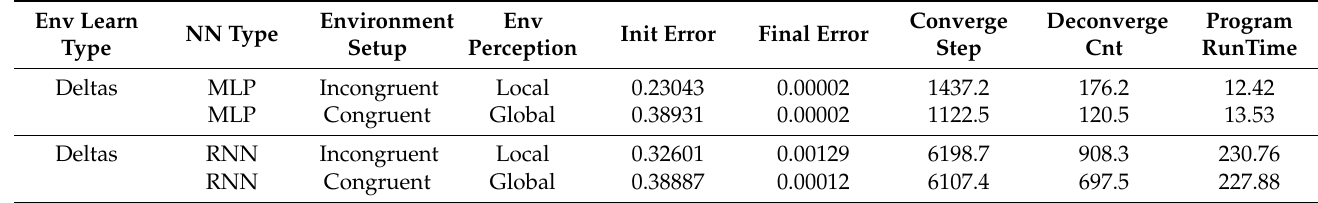
Table 7. Extending the Max Iteration